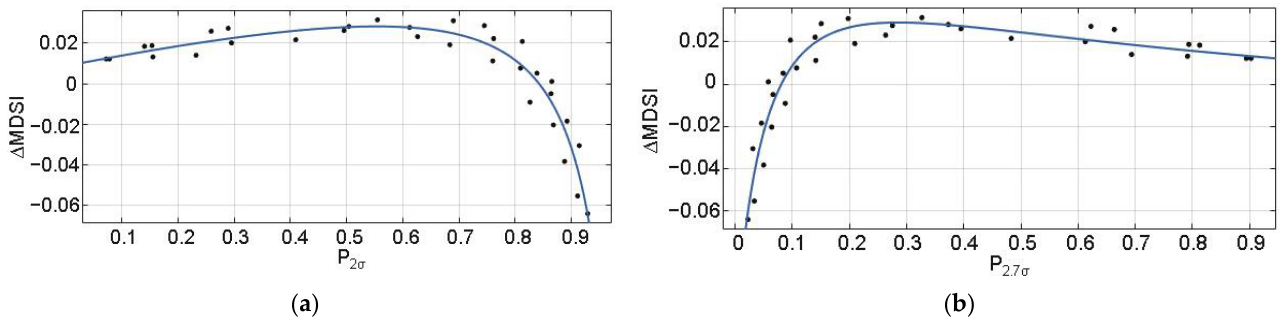
Figure 6. The scatter-plots ∆𝑴𝑫𝑺𝑰 vs. 𝑷 𝟐𝝈 ( a ) and vs. 𝑷 𝟐.𝟕𝝈 ( b ) and the fitted curves (format 4:4:4).